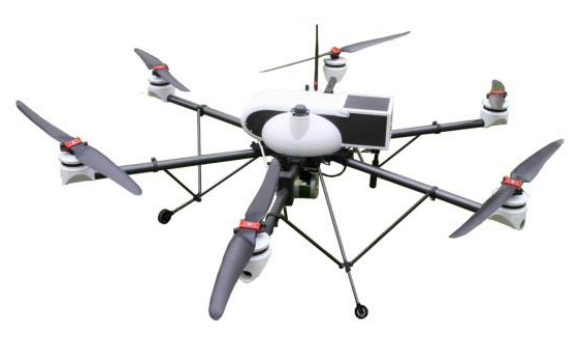
Figure 1: UAV AR200 (customized for ANKommEn) For ground based exploration tasks an UGV of type Robotnik Summit XL is used for carrying the NAV-Com-Stack (mounted inside the chassis), GNSS and data link antennas as well as visual sensors for exploration tasks, Figure